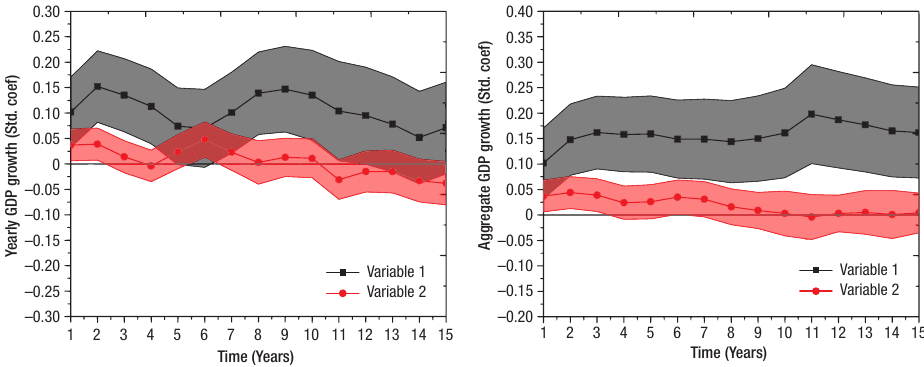
Fig. 1. Relation between the time scale and the standardized coefficients for the composite variables Notes: The composite variables represent the trade cycles for the aggregated trade between countries. Shaded areas depict a 95% confidence